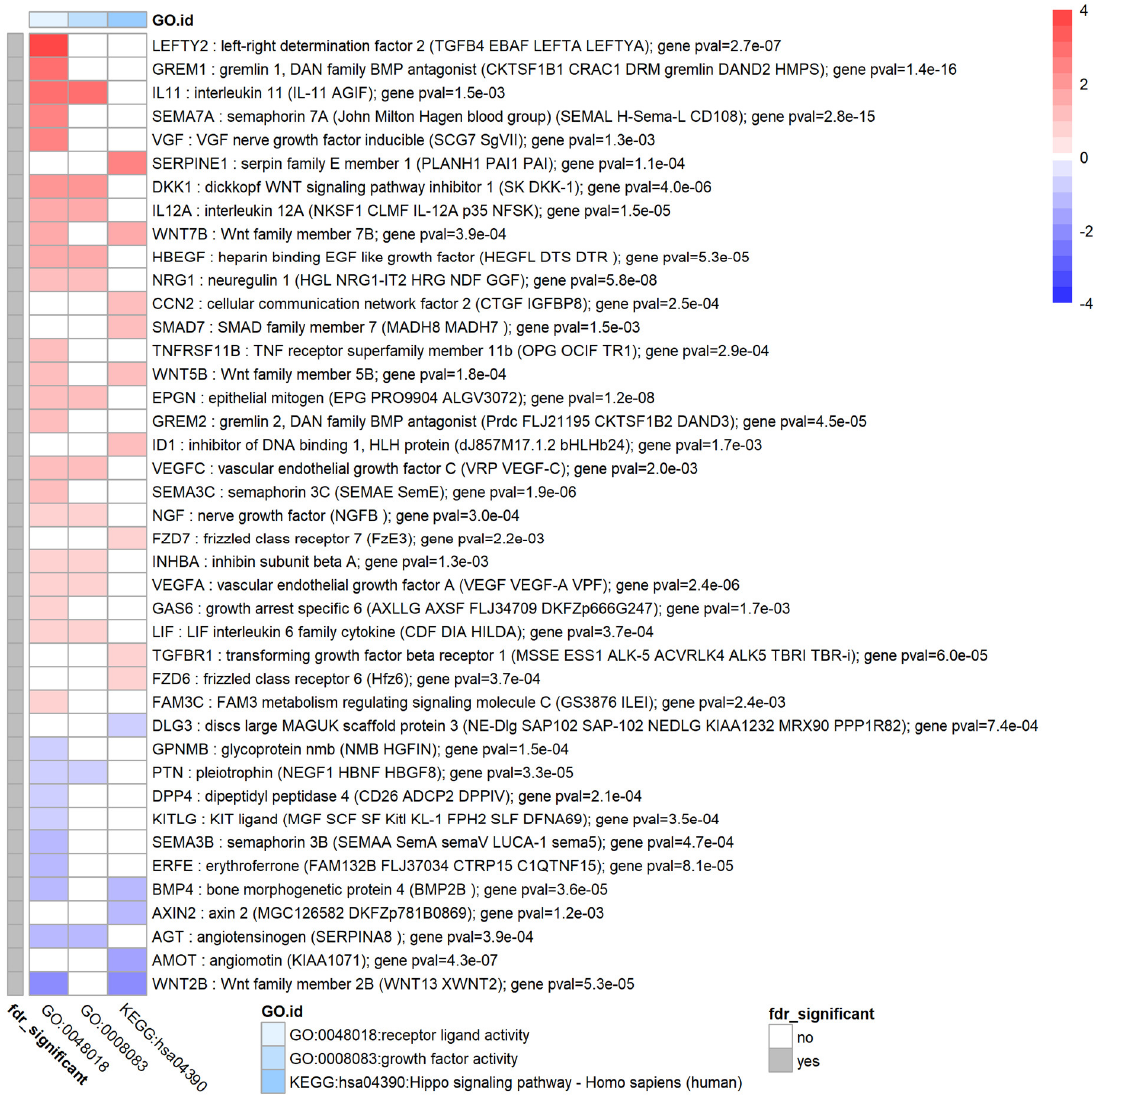
Figure 6. Genes and enrichment terms associated with extracellular signal molecules. Heatmap showing the genes with false discovery rate FDR < 0.05 for genes associated with growth factor activity and hippo signalling pathway. Heatmap colours correspond to fold change expressed as log 2 FC which has been limited to a range of [ − 4, 4] for clarity. The grey annotation bar on the left shows if the genome-wide false discovery rate is significant, FDR < 0.05 (in which FDR is the BH corrected p -value), for a particular gene which is the case for all genes considered